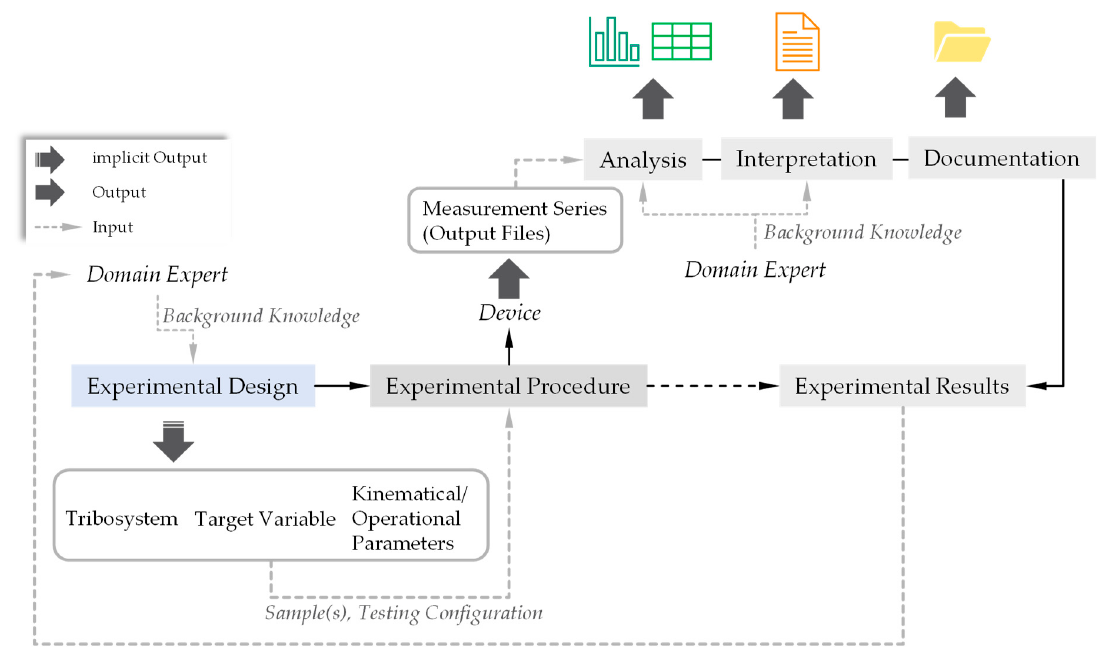
Figure 3. Process of producing experimental knowledge.